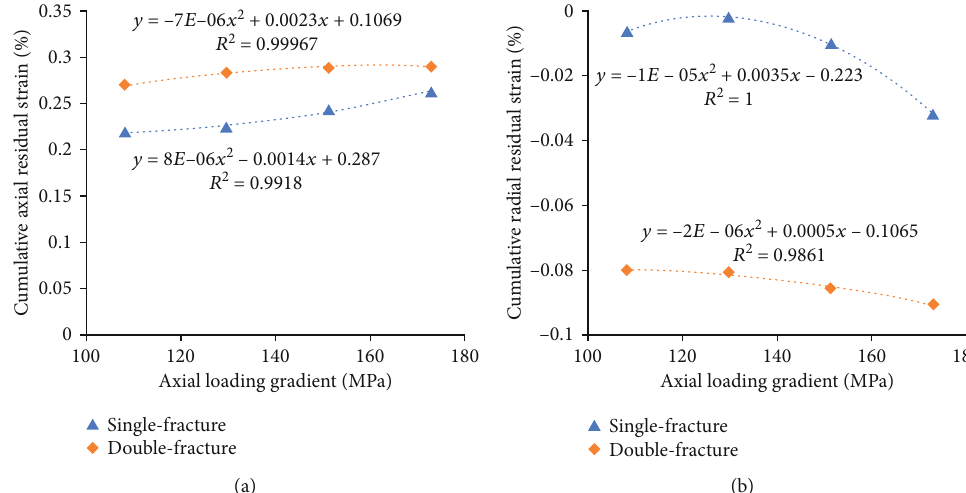
Figure 10: The residual strain at di ff erent cycle loading gradients: (a) cumulative axial residual strain; (b) cumulative radial residual strain.